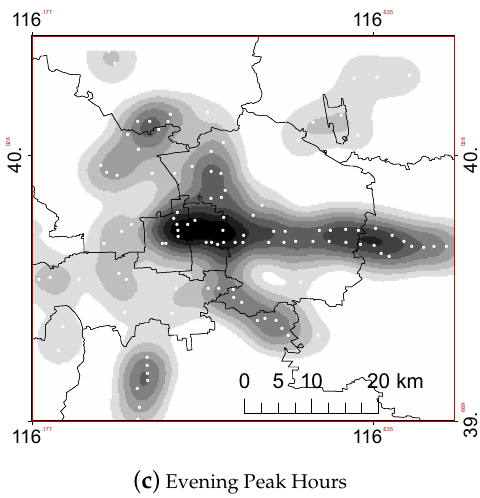
Figure 5. Kernel density of metro stations without EMS support.